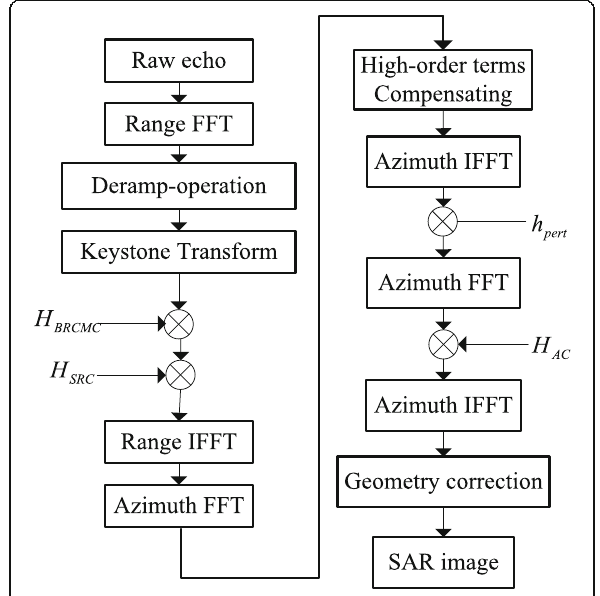
Fig. 10 The flowchart of the proposed